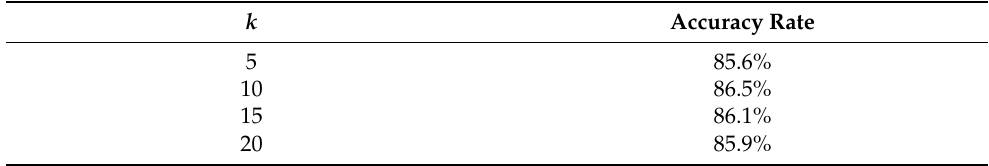
Table 4. Effects of taking different values of k on the recognition